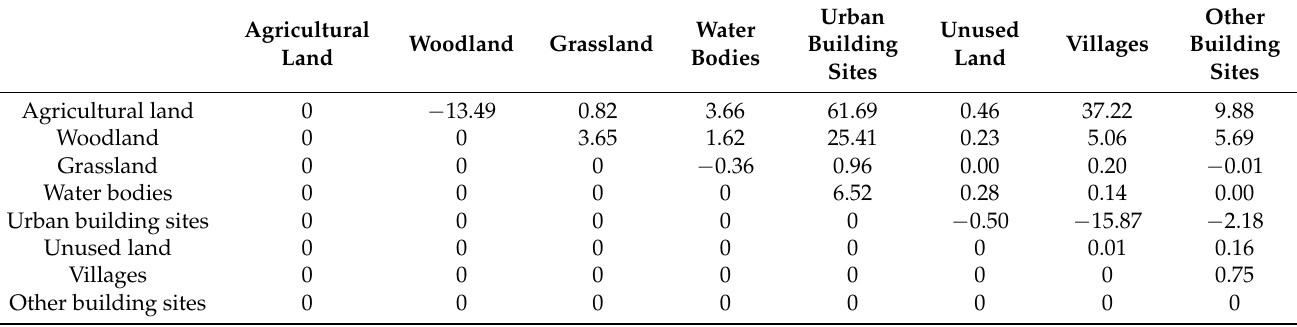
Table 6. Net land use transfer matrix between [2.5, 5] km buffer zone in Dalian. Agricultural Woodland Land